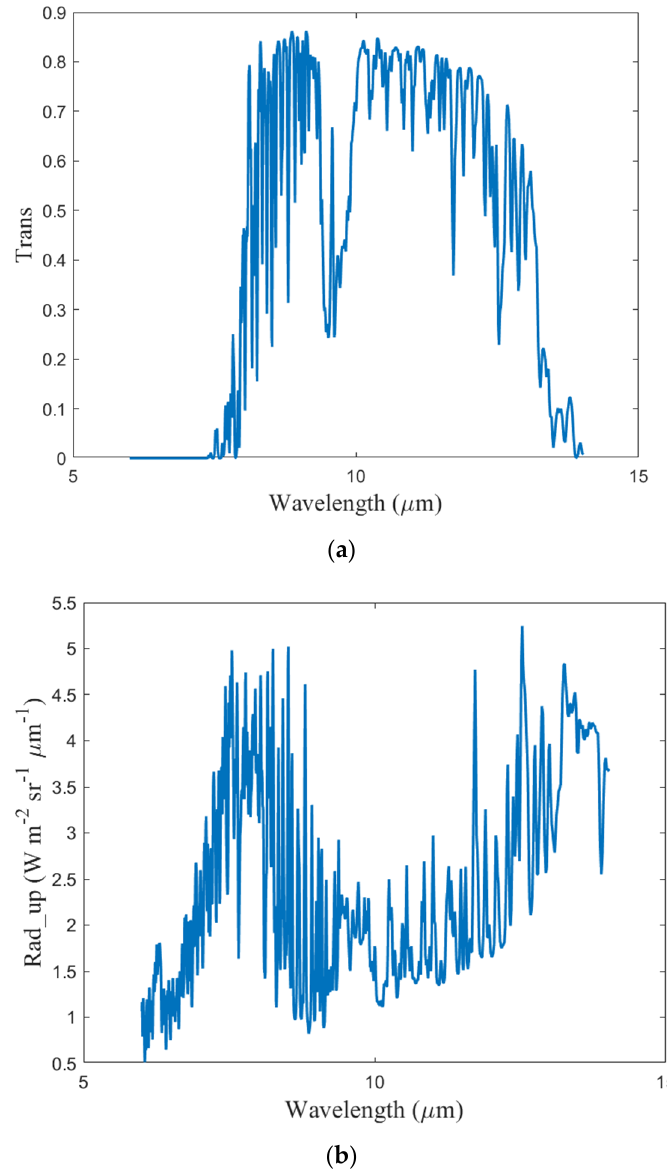
Figure 11. Atmospheric transmittance and upward radiation obtained by ECMWF for sensor1 and sensor2: ( a ) atmospheric transmittance; ( b ) upward radiation.